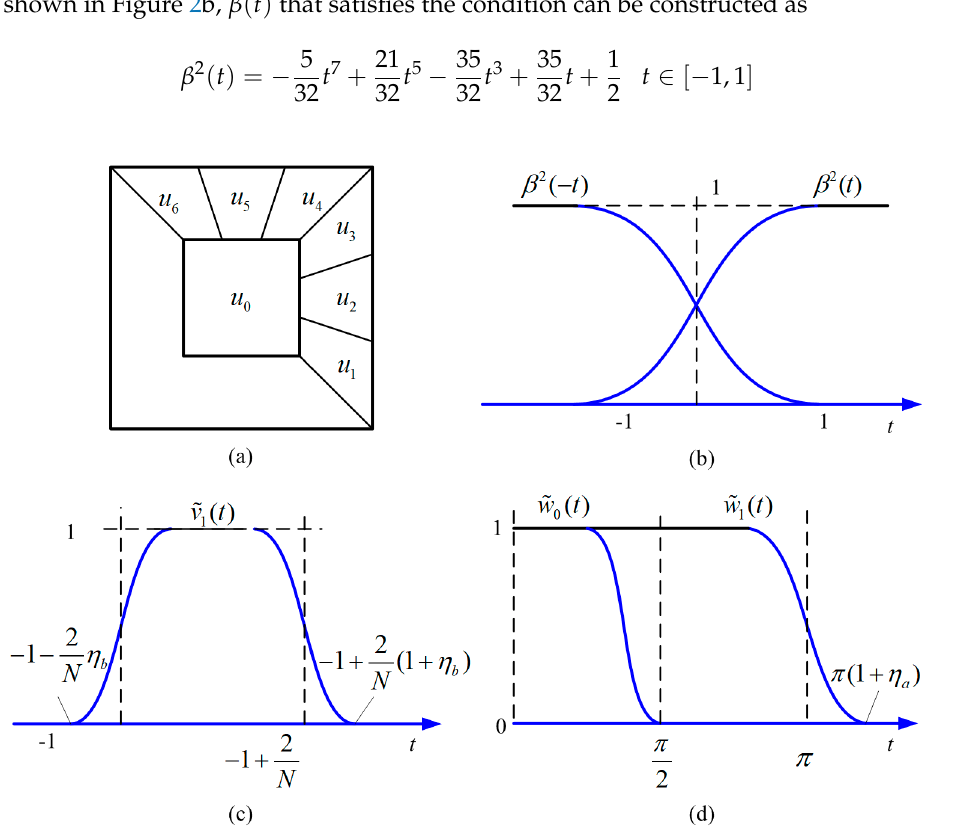
Figure 2. Structure of the Uniform Discrete Curvelet Transform (UDCT) window function: ( a ) Regions of essential support of u l ( ω ) ( N = 3); ( b ) One-dimensional smooth projection function; ( c ) Low-pass window function and the bandpass window function; ( d ) Angle window function.